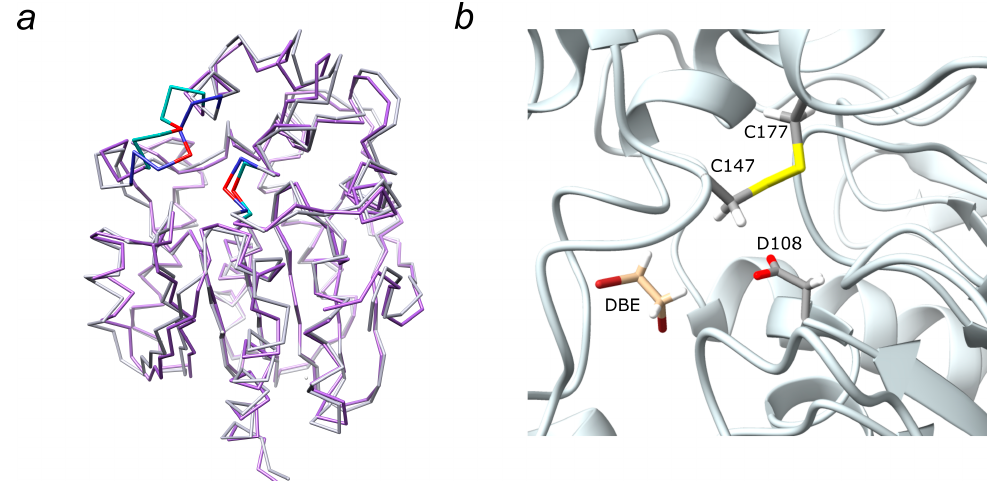
Figure 7. ( a ) Superposition of LinB D147C+L177C (purple) with LinB MD D147C+L177C (grey). The residues 144–150 and 176–178 of LinB D147C+L177C are highlighted in turquoise, the residues 144–150 and 176–178 of LinB MD D147C+L177C obtained from molecular dynamics simulations are in dark blue. Cys 147 and Cys 177 are in red. ( b ) 1,2-dibromethane (DBE) docked in the active site of LinB MD D147C+L177C. Cysteine bridge C147–C177 and nucleophilic D108 are shown as